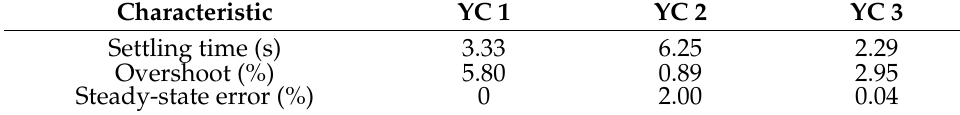
Table 8. Comparison of performance characteristics for the different yaw control (YC) cases.